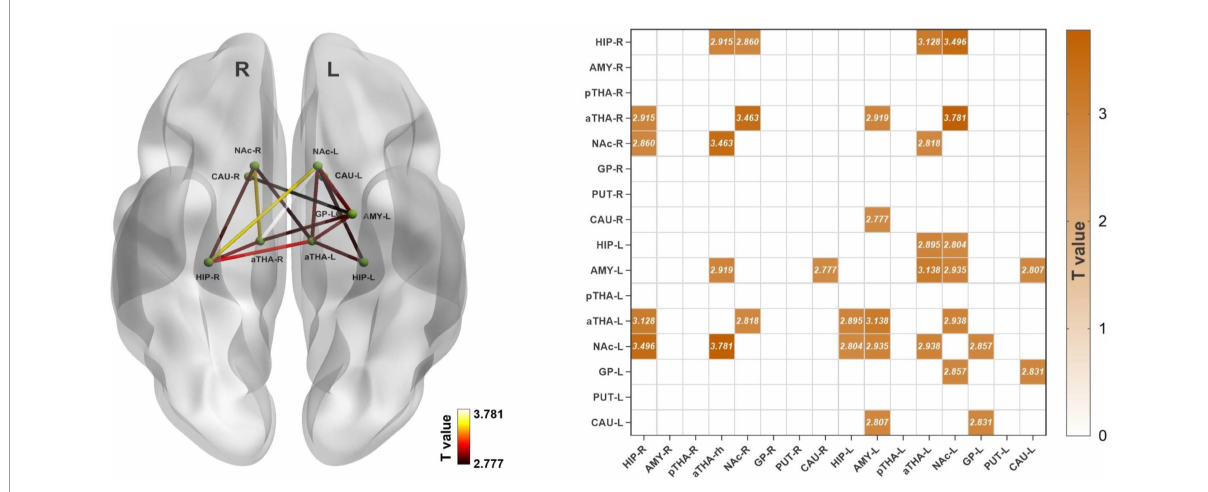
aTHA_R, right anterior thalamus; NAc_R, right nucleus accumbens; GP_R, right globus pallidus; PUT_R, right putamen; CAU_R, right caudate nucleus; HIP_L, left hippocampus; AMY_L, left amygdala; pTHA_L, left posterior thalamus; aTHA_L, left anterior thalamus; NAc_L, left nucleus accumbens; GP_L, left globus pallidus; PUT_L, left putamen; CAU_L, left caudate nucleus. The coordinate of the subcortical regions was provided in Supplementary material 1